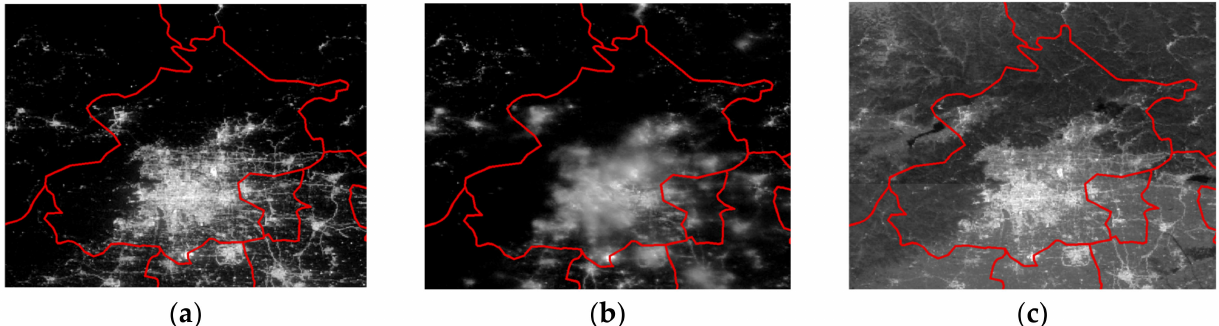
Figure 4. VIIRS DNB images under different conditions: ( a ) No cloud and moonlight pollution. ( b ) Images contaminated by clouds. ( c ) Images polluted by